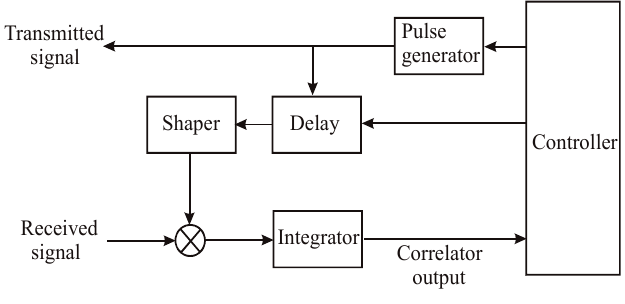
Figure 16. Schematic representation of correlation-based